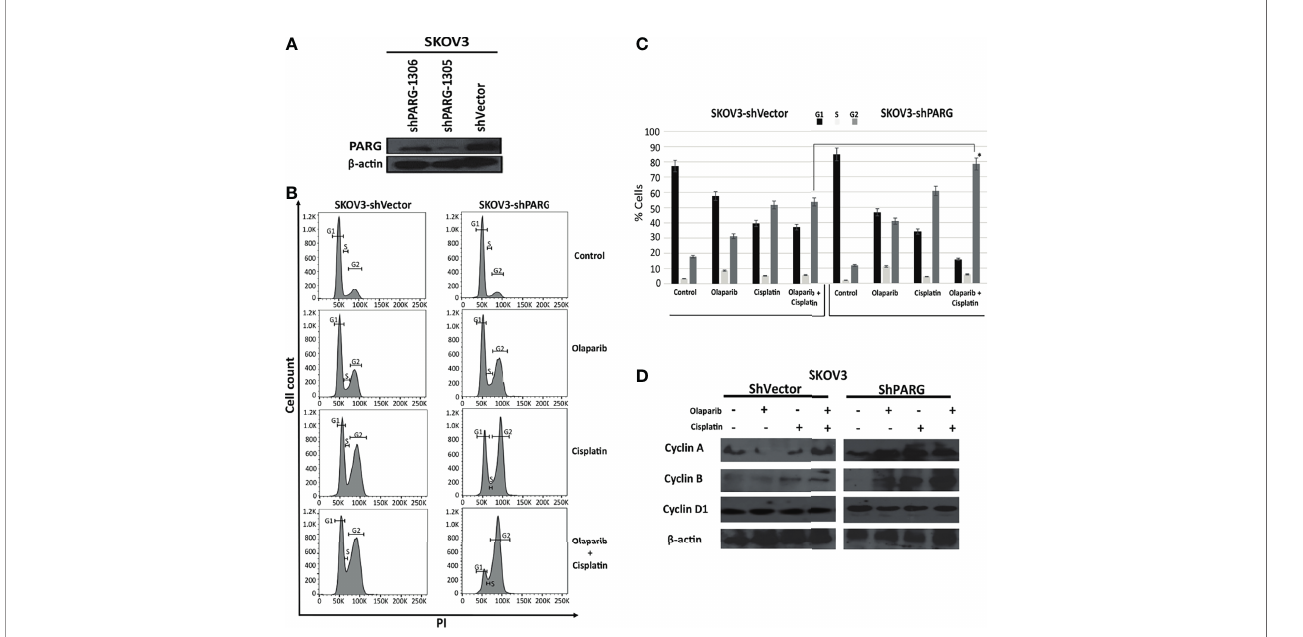
FIGURE 5 | PARG silencing induces G2/M arrest inovarian cancer cells treatedwith Olaparib and Cisplatin. Expression of PARG inSKOV3-shVectorand SKOV3_shPARG celllines (A) . SKOV3-shVector and SKOV3_shPARG cells were treated with Olaparib 2 m M,Cisplatin 1 m g/mLand combination of Olaparib andCisplatin for 48 hours. Cells were synchronized, andcellcycleanalysis were performed using fl ow cytometry (B, C) . Protein expression of cell cyclerelated proteins (cyclin A, cyclin B andcyclin D1) were examinedby western blot (D) . Results are presentedas means± SEM for triplicates of three independent experiments, *p value <